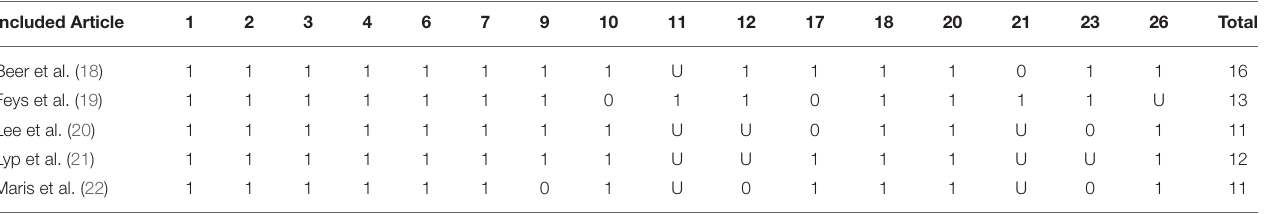
TABLE 1 | Article quality assessment using Downs and Black checklist.